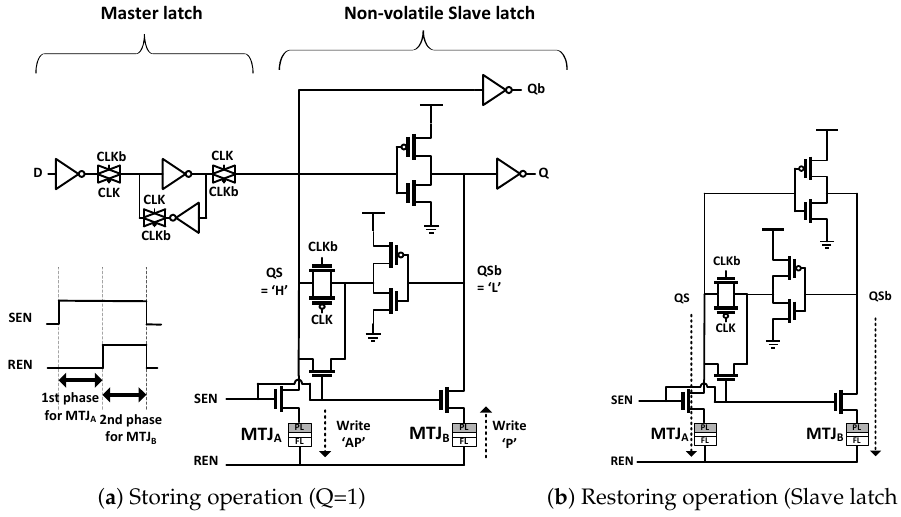
Figure 1. Schematic of an non-volatile flip flop (NVFF) of Yamamoto et al.